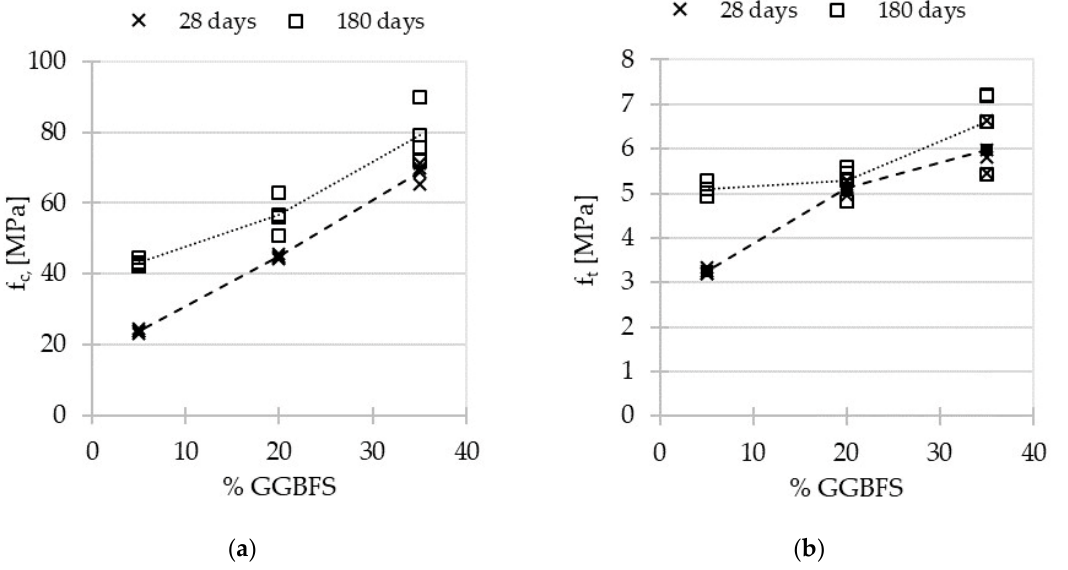
Figure 4. Mechanical properties of alkali-activated concretes after 28 and 180 days: ( a ) compressive strength (f c ); ( b ) splitting tensile strength (f t ).